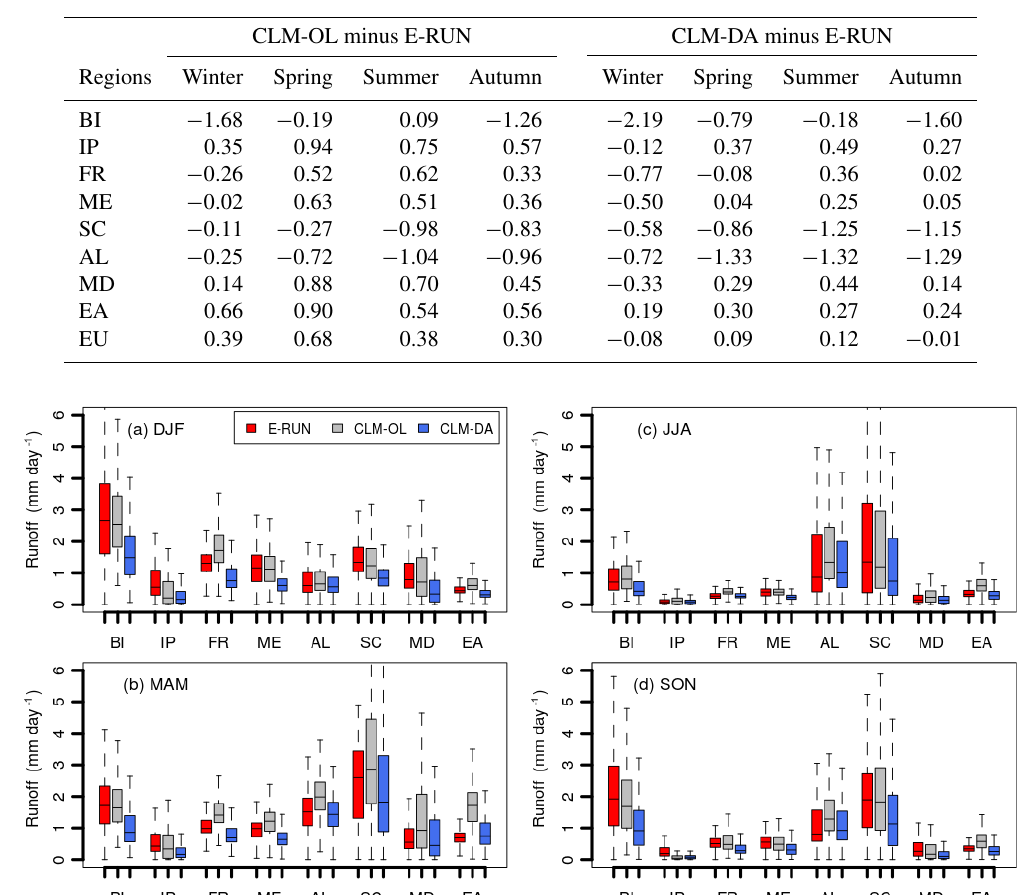
Figure 8. Box plots of temporally averaged runoff (mmday − 1 ) over the years 2000–2006 for all PRUDENCE region and seasons, i.e., (a) DJF, (b) MAM, (c) JJA and (d) SON. The box plots indicate the spatial distribution of monthly averaged runoff over each